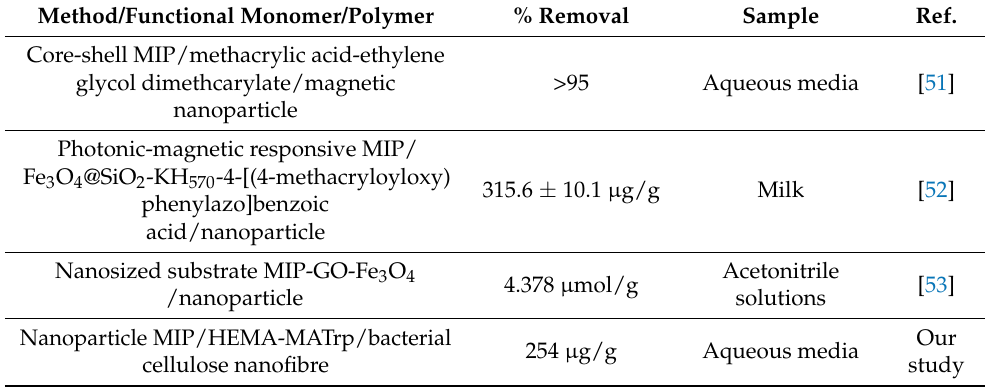
Table 5. Cont. Method/Functional